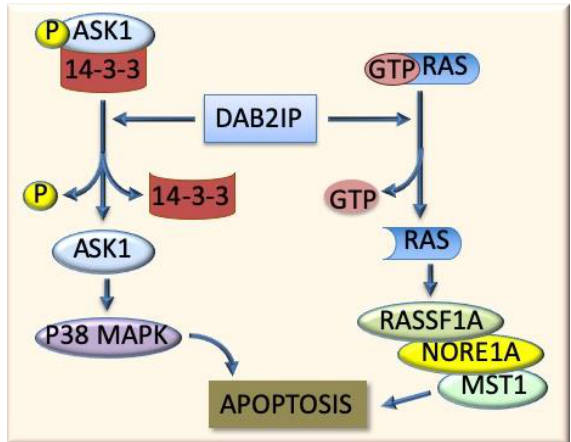
Figure 4. Apoptogenic role of Dab2IP protein. This protein, by impeding the formation of the complexes P-ASK1/14-3-3 and GTP/RAS, induces the activation of the apoptogenic P38 MAPK and RassF1A/Nore1A/Mst1.